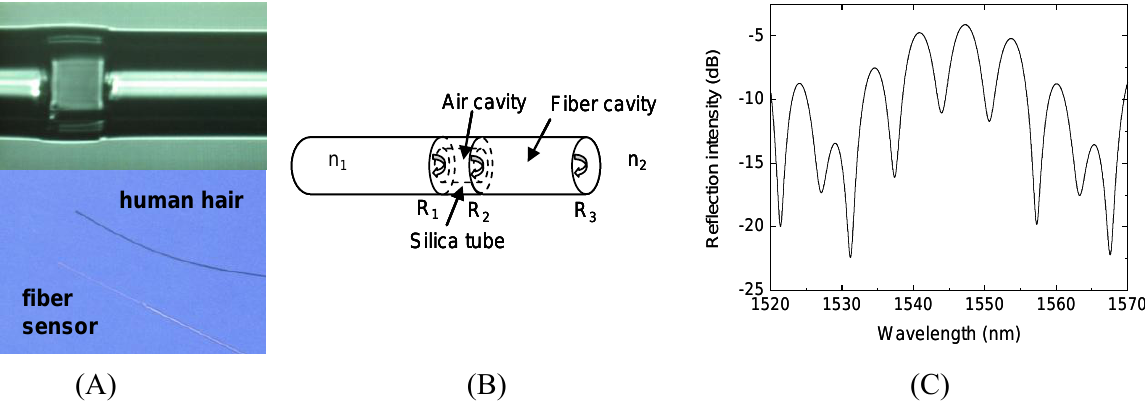
Figure 2. Multi-cavity FP sensor structure and representative interference